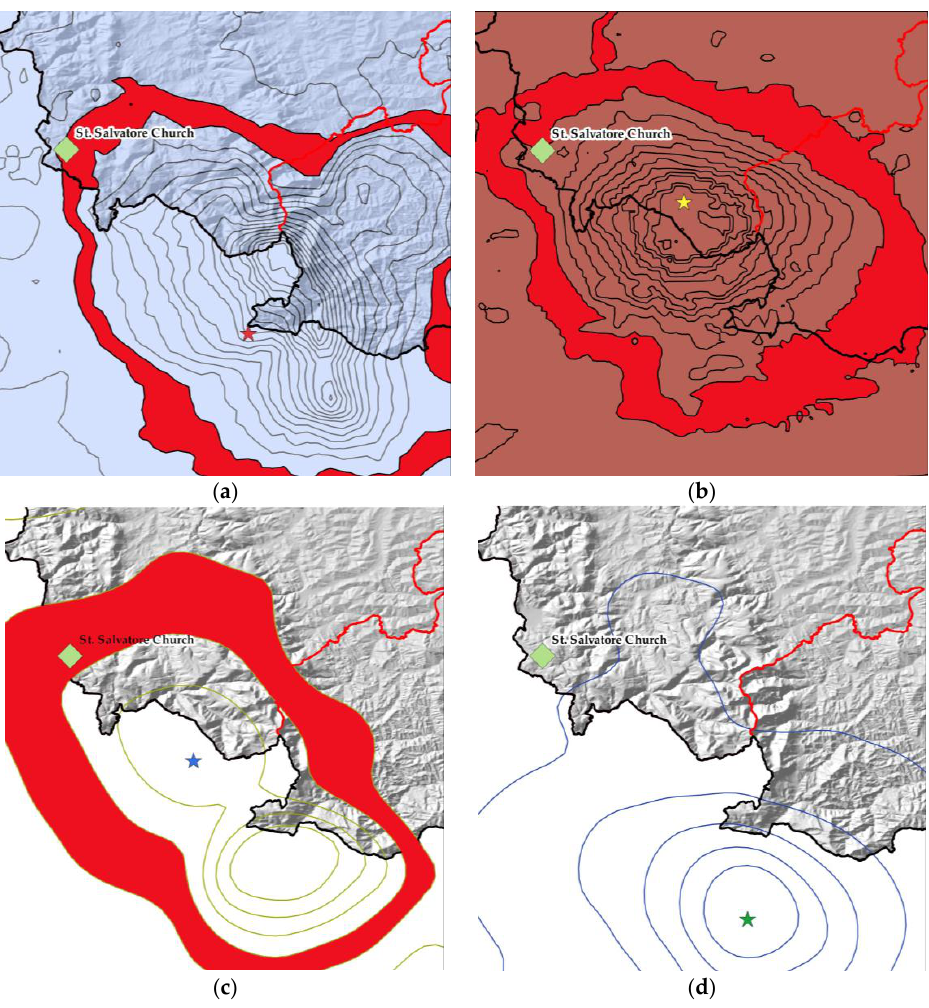
Figure 15. PGA isocurves of the main shocks. ( a ) Event of 24 August (12% g); the epicenter is the red star [58]; ( b ) event of 26 October (8% g); the epicenter is the yellow star [59]; ( c ) event of 30 October (12% g); the epicenter is the blue star [60]; ( d ) Event of 18 January (2.5% g); the epicenter is the green star [61].